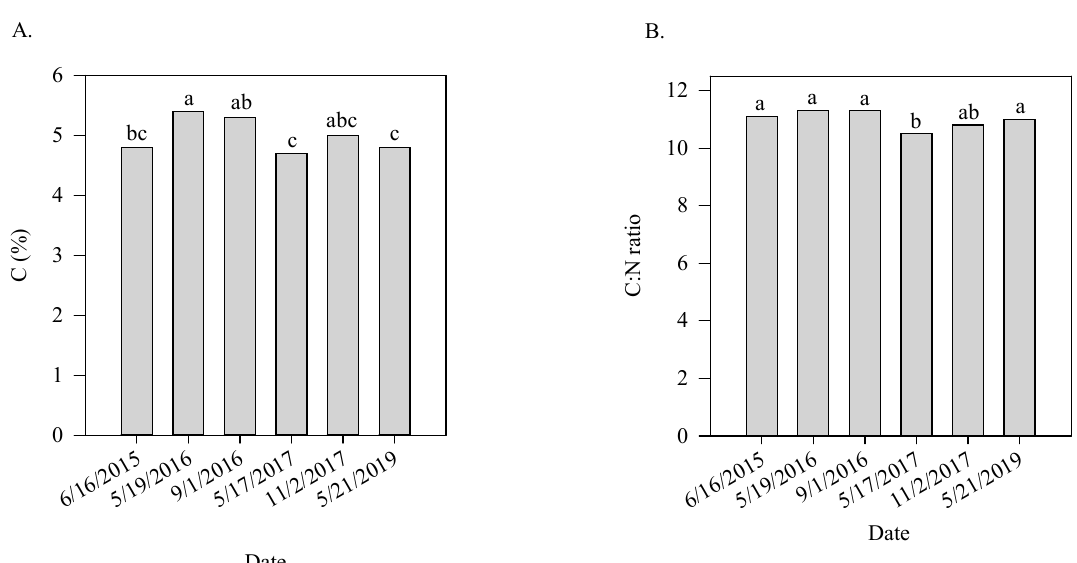
Figure 3. C ( A ) and C:N ratio ( B ) as a function of sampling date in Minnesota site. Means followed by different letters are significantly different ( p -value ≤ 0.05).